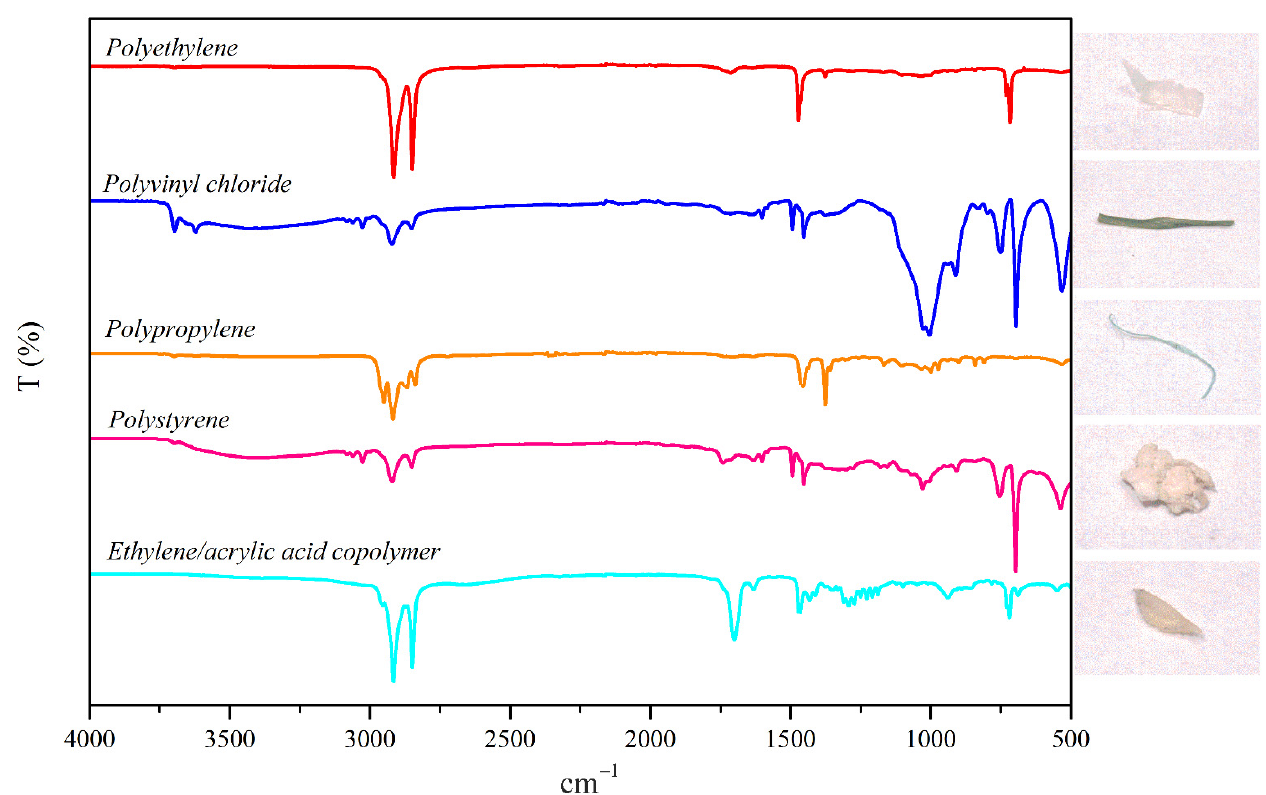
Figure 8. MPs compositions of selected samples identified by micro–FTIR.